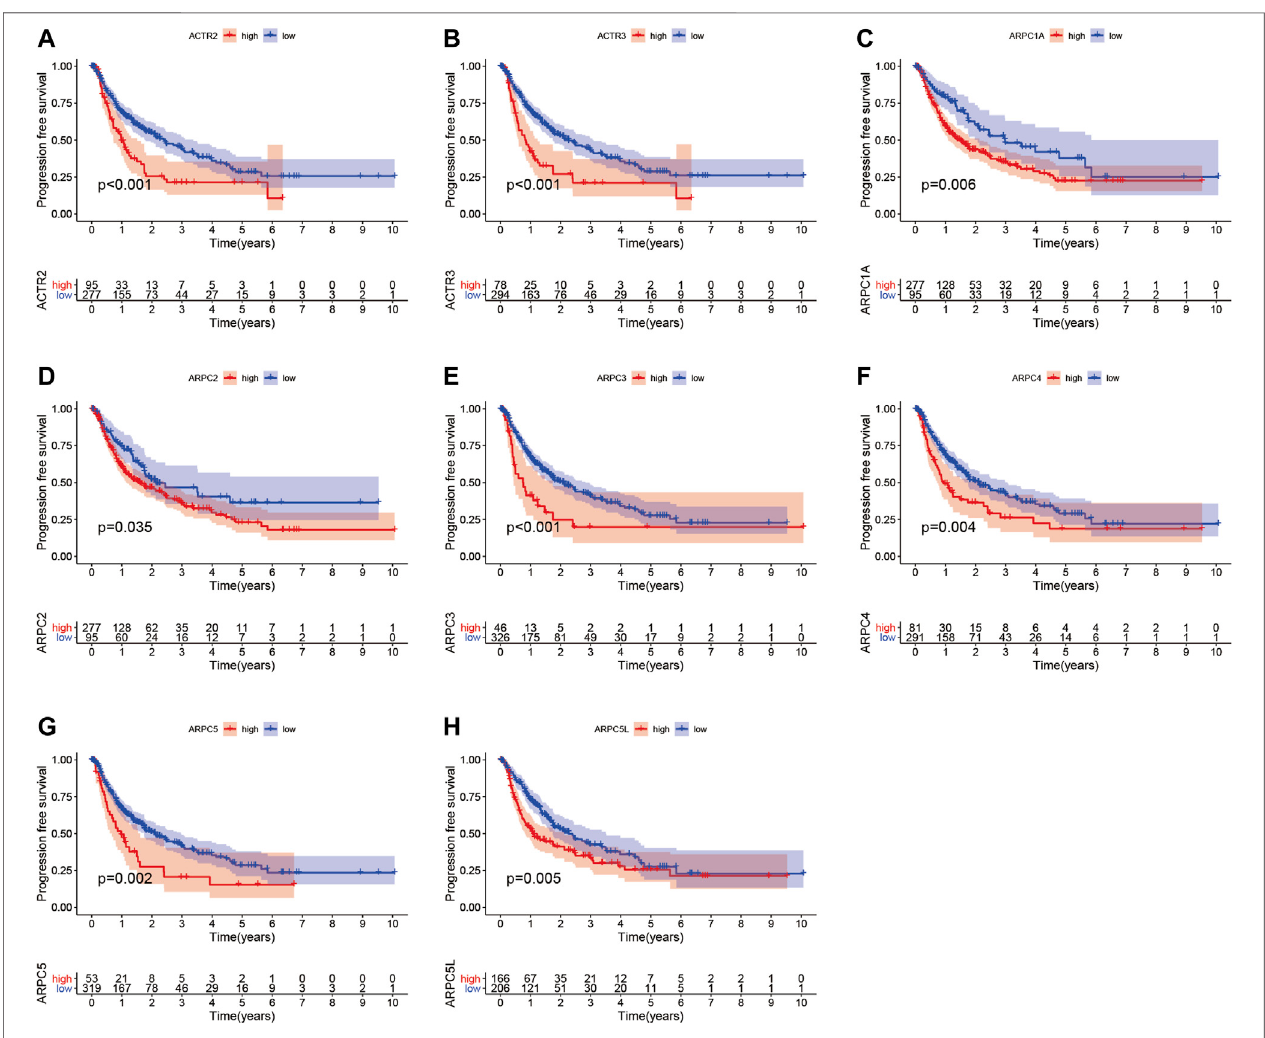
FIGURE8 | Kaplan – Meier survival analysis ofthe association between mRNA expression ofArp2/3 complex members and progression-free survival (PFS) in HCC patients (A – H) . The information of HCC samples was derived from the TCGA and UCSC Xena databases.